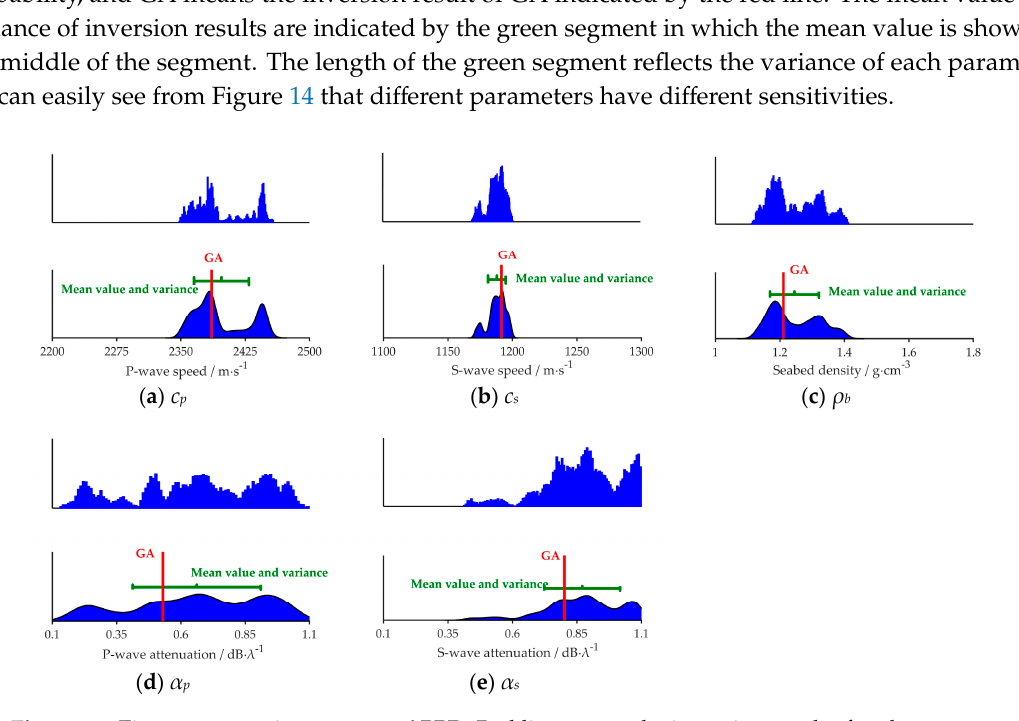
Figure 15 represents the 2D marginal of the PPDs, where the dashed white line indicates the GA inversion result of each parameter, and the values of the variance represent the magnitude of the